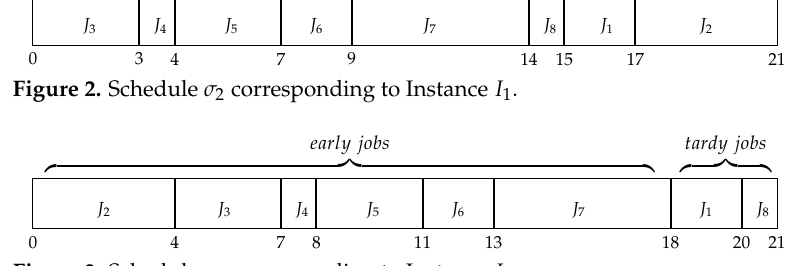
Figure 3. Schedule σ 3 corresponding to Instance I 1